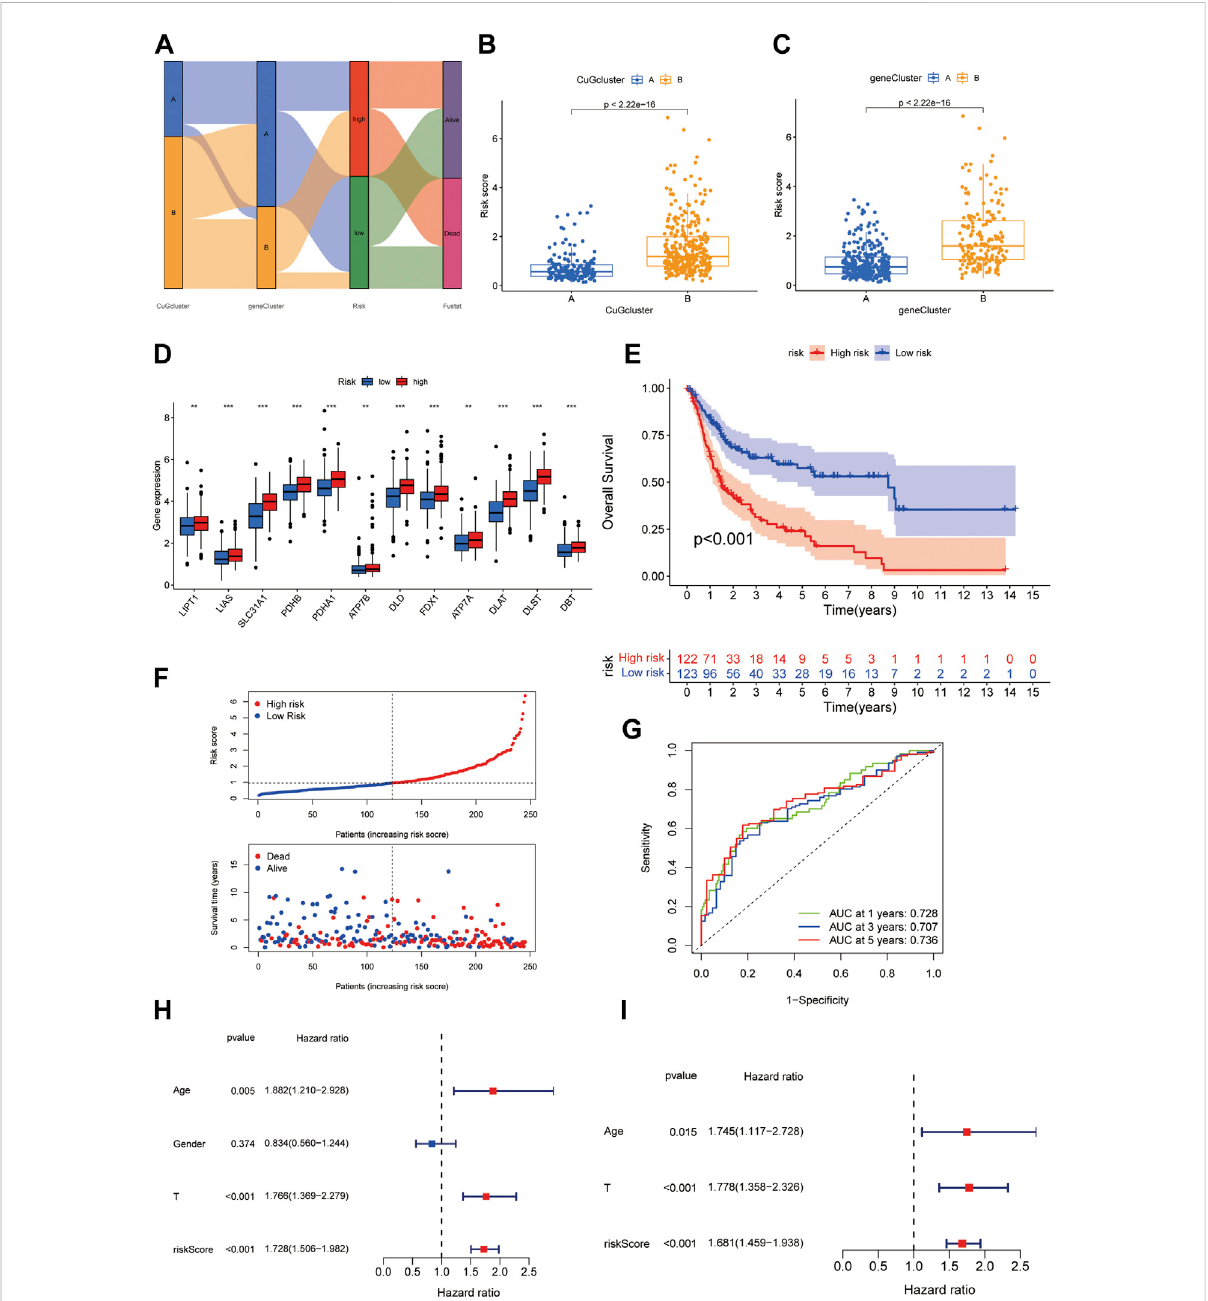
FIGURE 5 Generation of the cuproptosis scoring system to predict survival of BLCA patients. (A) Alluvial diagram of two cuproptosis patterns, two gene clusters, cuproptosis scores, and survival status. (B,C) Boxplot depicted the differences in cuproptosis scores between the cuproptosis patterns (B) andgeneclusters (C) . (D) BoxplotshowedthedifferentCuGsexpressioninthetworiskgroups. (E) Kaplan-Meiersurvivalanalysisforpatientsinhigh- andlow-riskgroupsinthetrainingcohort. (F) Thedistributionoftheriskscores,OSstatues,andthecorrelationsbetweenOSandriskscores. (G) ROC curve of the cuproptosis risk scoring system for prediction of OS in the training cohort. (H) Results of the univariate Cox regression analyses regarding OS in the training cohort. The risk score was signi fi cantly associated with the OS. (I) Results of the multivariate Cox regression analyses regarding OS in the training cohort. The risk score was an independent prognostic factor. * p < 0.05, ** p < 0.01, *** p < 0.001. Abbreviations: CuG, cuproptosis genes; OS, overall survival; ROC, receiver operating